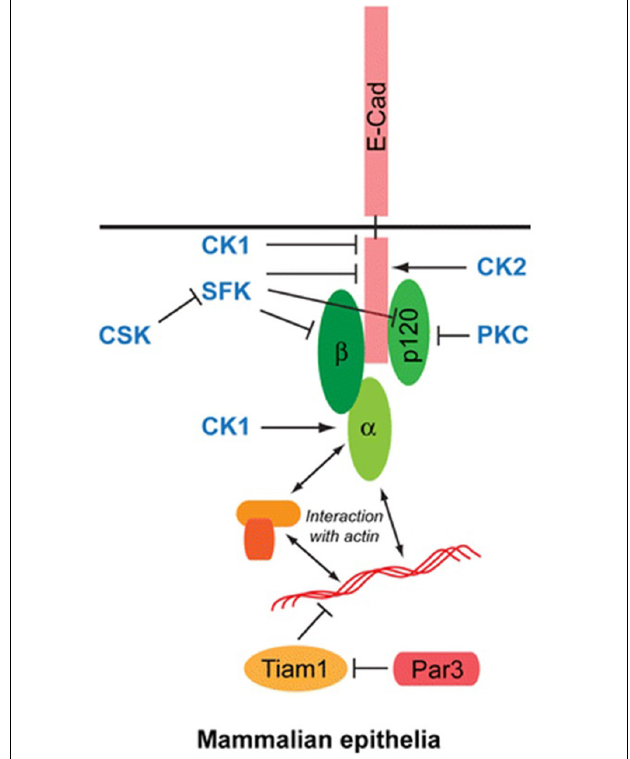
FIGURE 3 | Structure of E-cadherin molecule: The cytoplasmic domain of E-cadherin interacts with two main molecules: β -catenin ( β -Cat) and p120-catenin (p120-Ctn). Binding of β -Catenin with actin filaments is mediated by α -Catenin ( α -Cat).